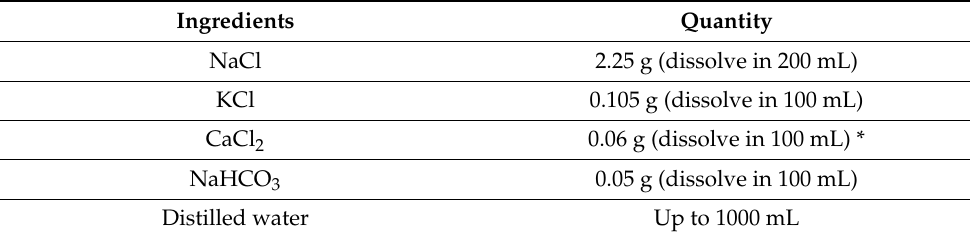
Table A3. Preparation of sterile Ringer Solution (1000 mL)